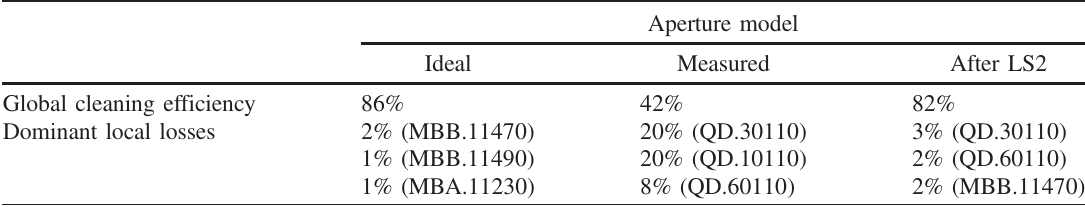
TABLE VI. Global cleaning efficiency and dominant local losses for three considered aperture models.